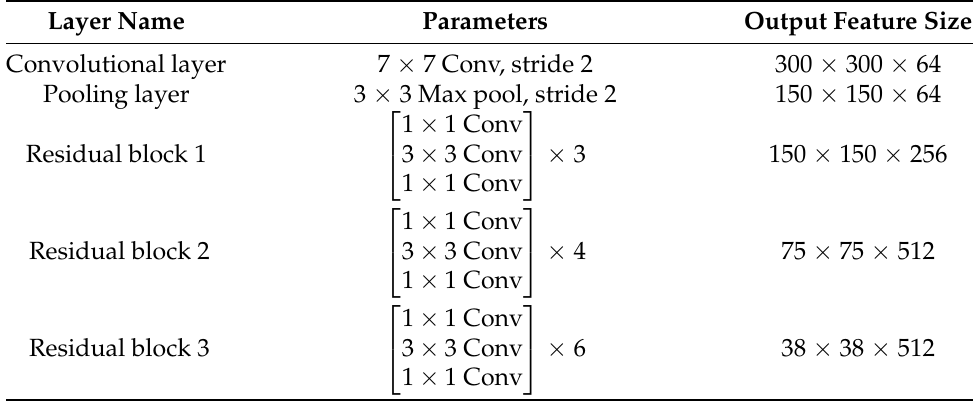
Figure 1. Flowchart of the proposed SAR target detection method. Table 1. ResNet feature extraction structure